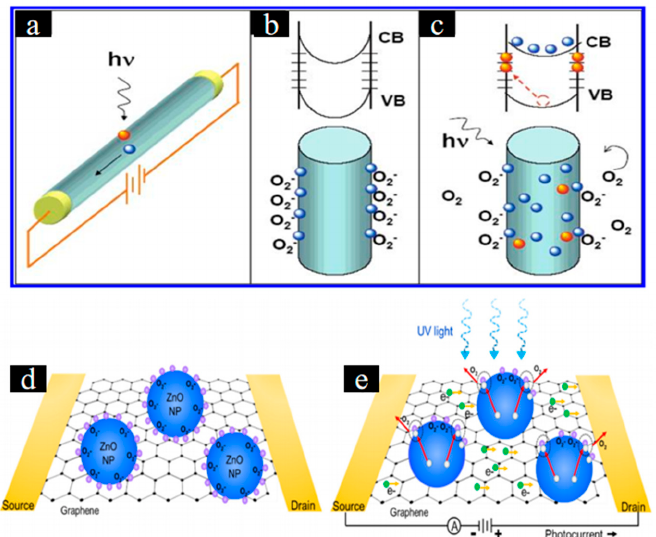
Figure 4. ( a – c ) Photoconduction in ZnO nanowire (NW) photodetectors. ( a ) Schematic of a ZnO NW photoconductor. ( b , c ) Schematic of trapping and photoconduction mechanism in ZnO NWs ( a )